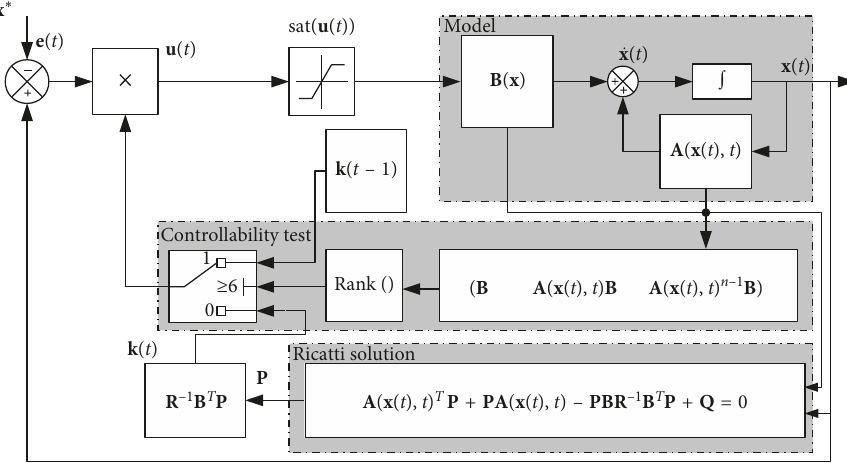
Figure 9: Block diagram of the system with control applied to the DC motor.